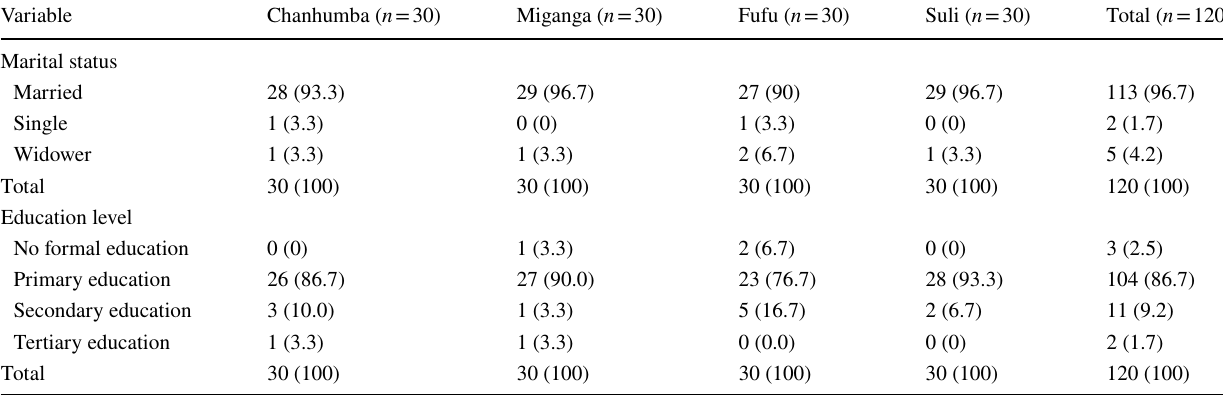
Table 2 Respondents’ marital status and education level ( n = 120)